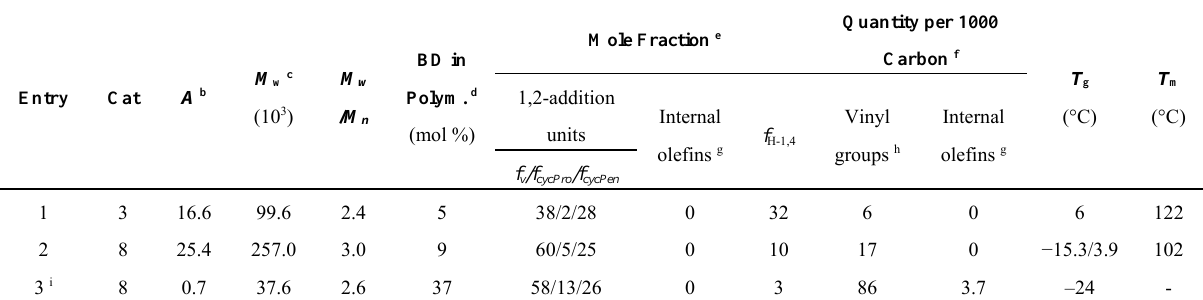
Table 2. Propylene/butadiene copolymerization results using complexes 1 – 8 a